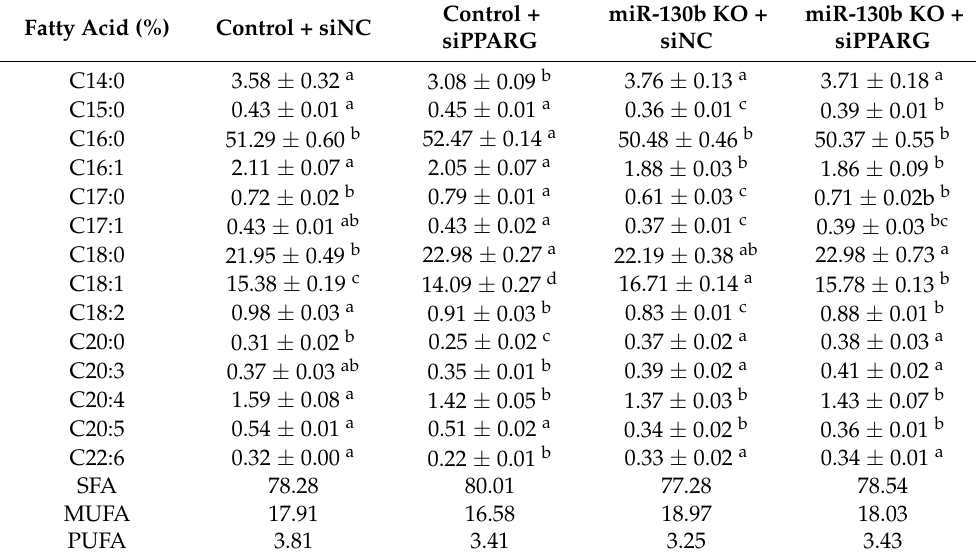
Table 2. Effects of PPARG Silencing on miR-130b Knockout Mediating Fatty Acid Composition Change.